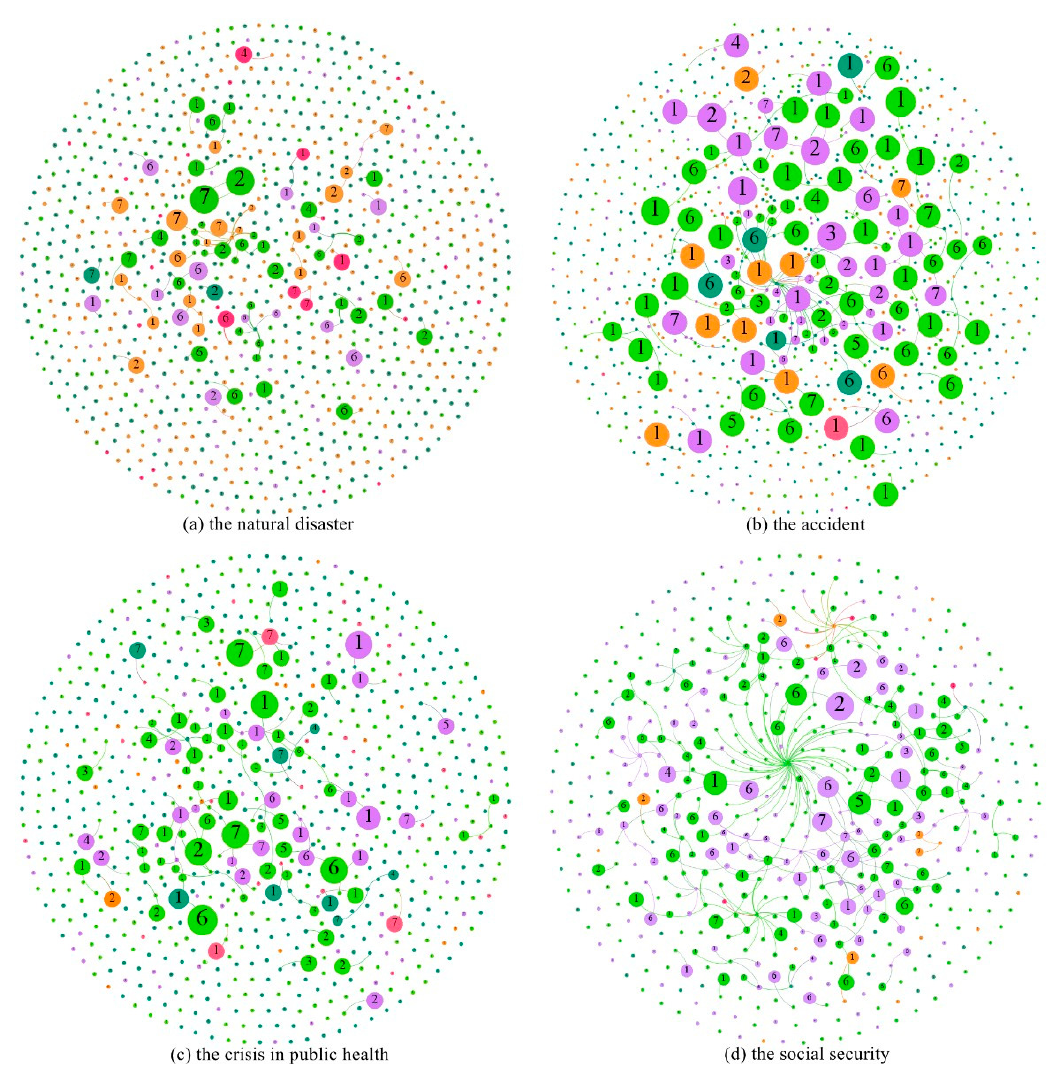
Figure 5. Emotion propagation maps of four events. Label 1 represents the emotion of “Like”, Label 2 represents the emotion of “Disgust”, Label 3 represents the emotion of “Surprise”, Label 4 represents the emotion of “Happiness”, Label 5 represents the emotion of “Fear”, Label 6 represents the emotion of “Sadness”, and Label 7 represents the emotion of “Anger”.